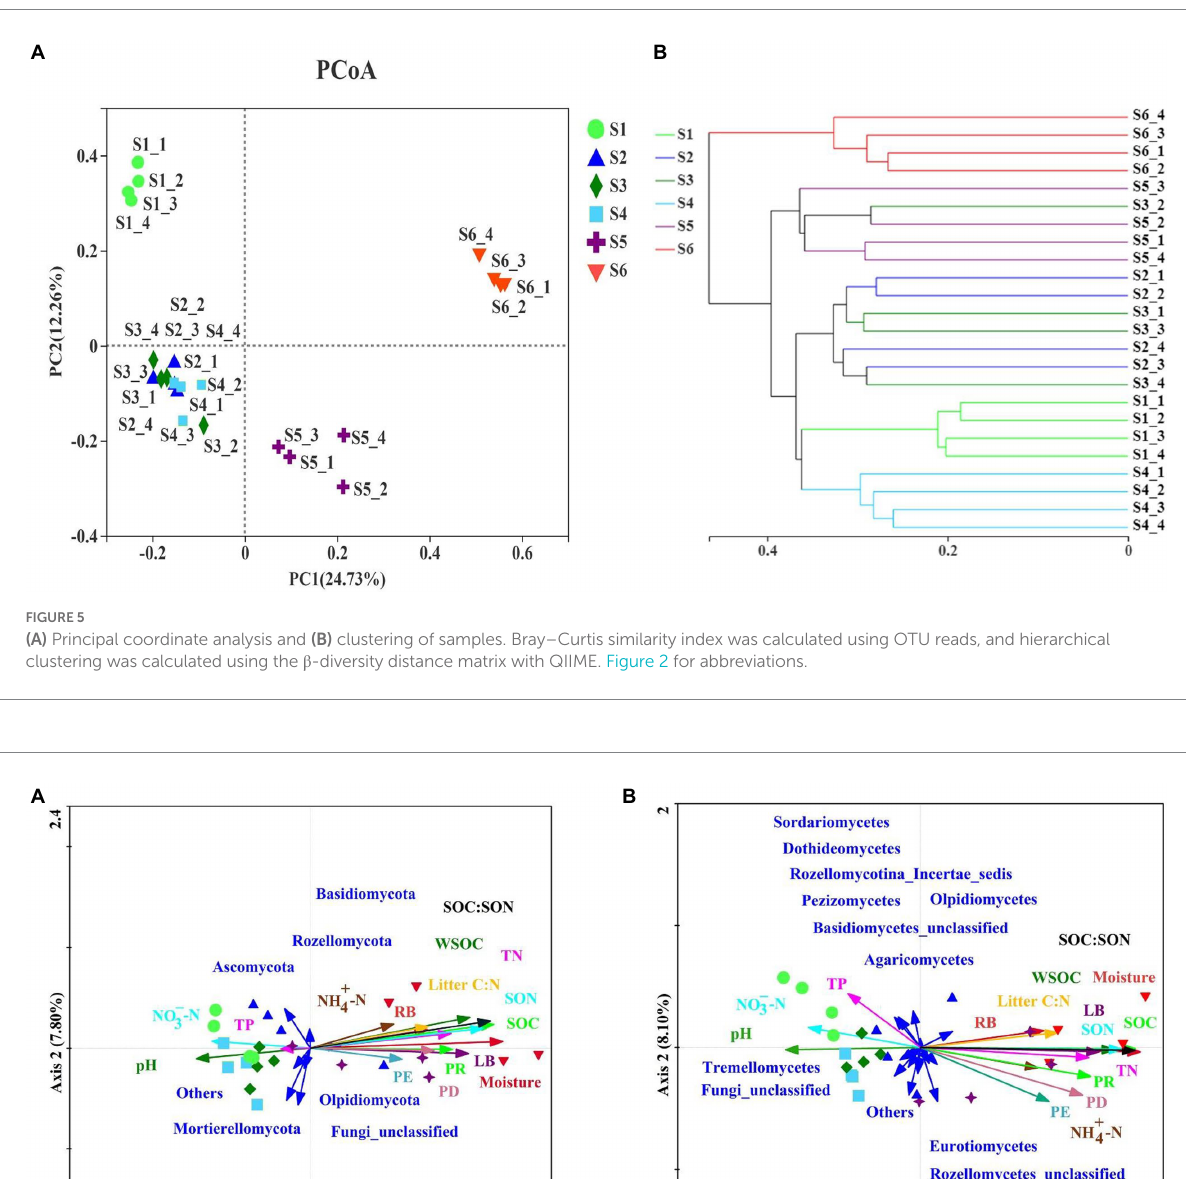
of Undefined fungi, AMF, and Fungal Parasites had a significantly negative correlation with the soil moisture, SOC, WSOC, TN, SON, and SOC:SON (Table 5).